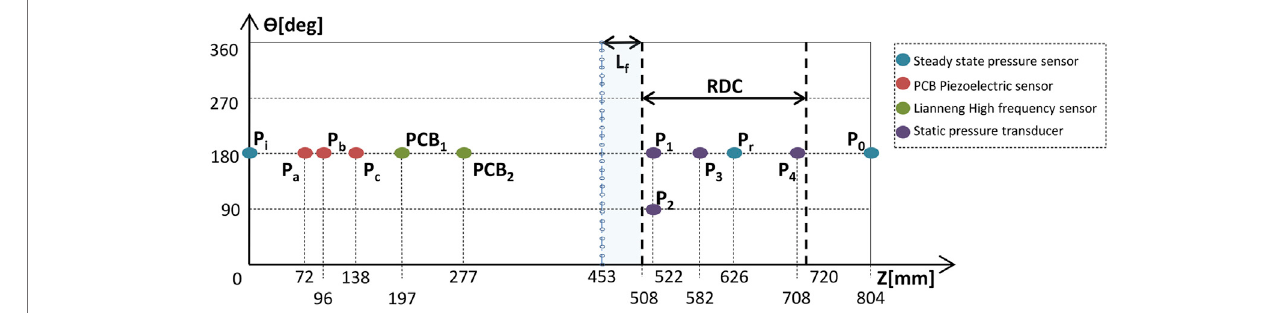
FIGURE 3 | Locations of the sensors.